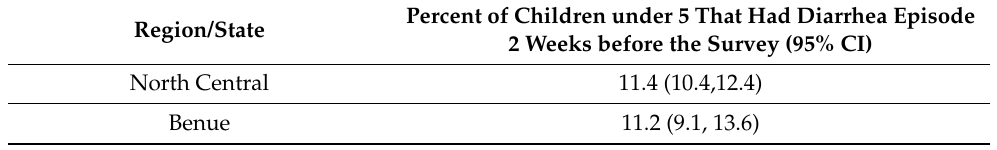
Table A1. Point and interval estimates of children under 5 that had diarrhea episode 2 weeks before the survey by Regions and